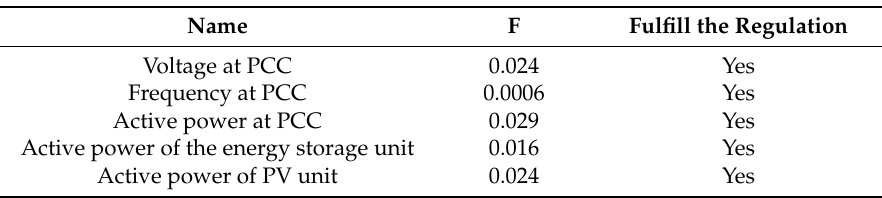
Table 4. Errors in case 1 condition.